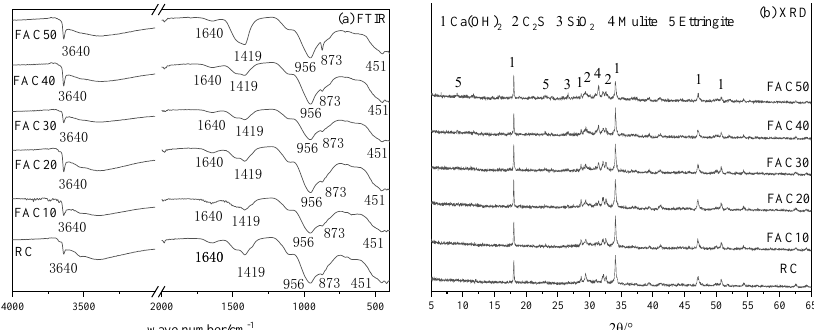
Figure 5. FTIR and XRD spectrum of pastes at 28 d: ( a ) FTIR; ( b ) XRD.